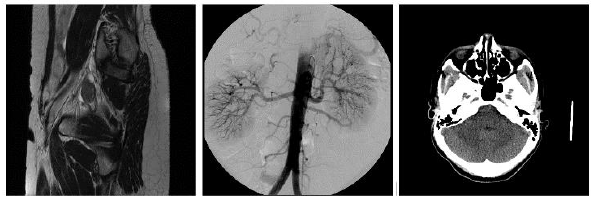
Figure 4. Test samples used in the experiments, from left to right (MRI, X-Ray and CT) scans.